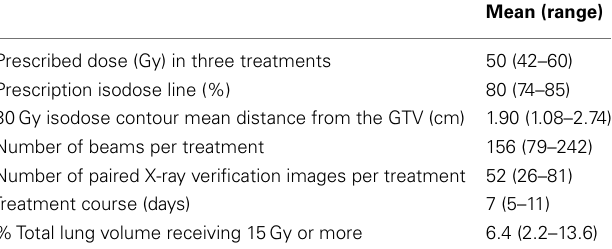
Table 3 |Treatment